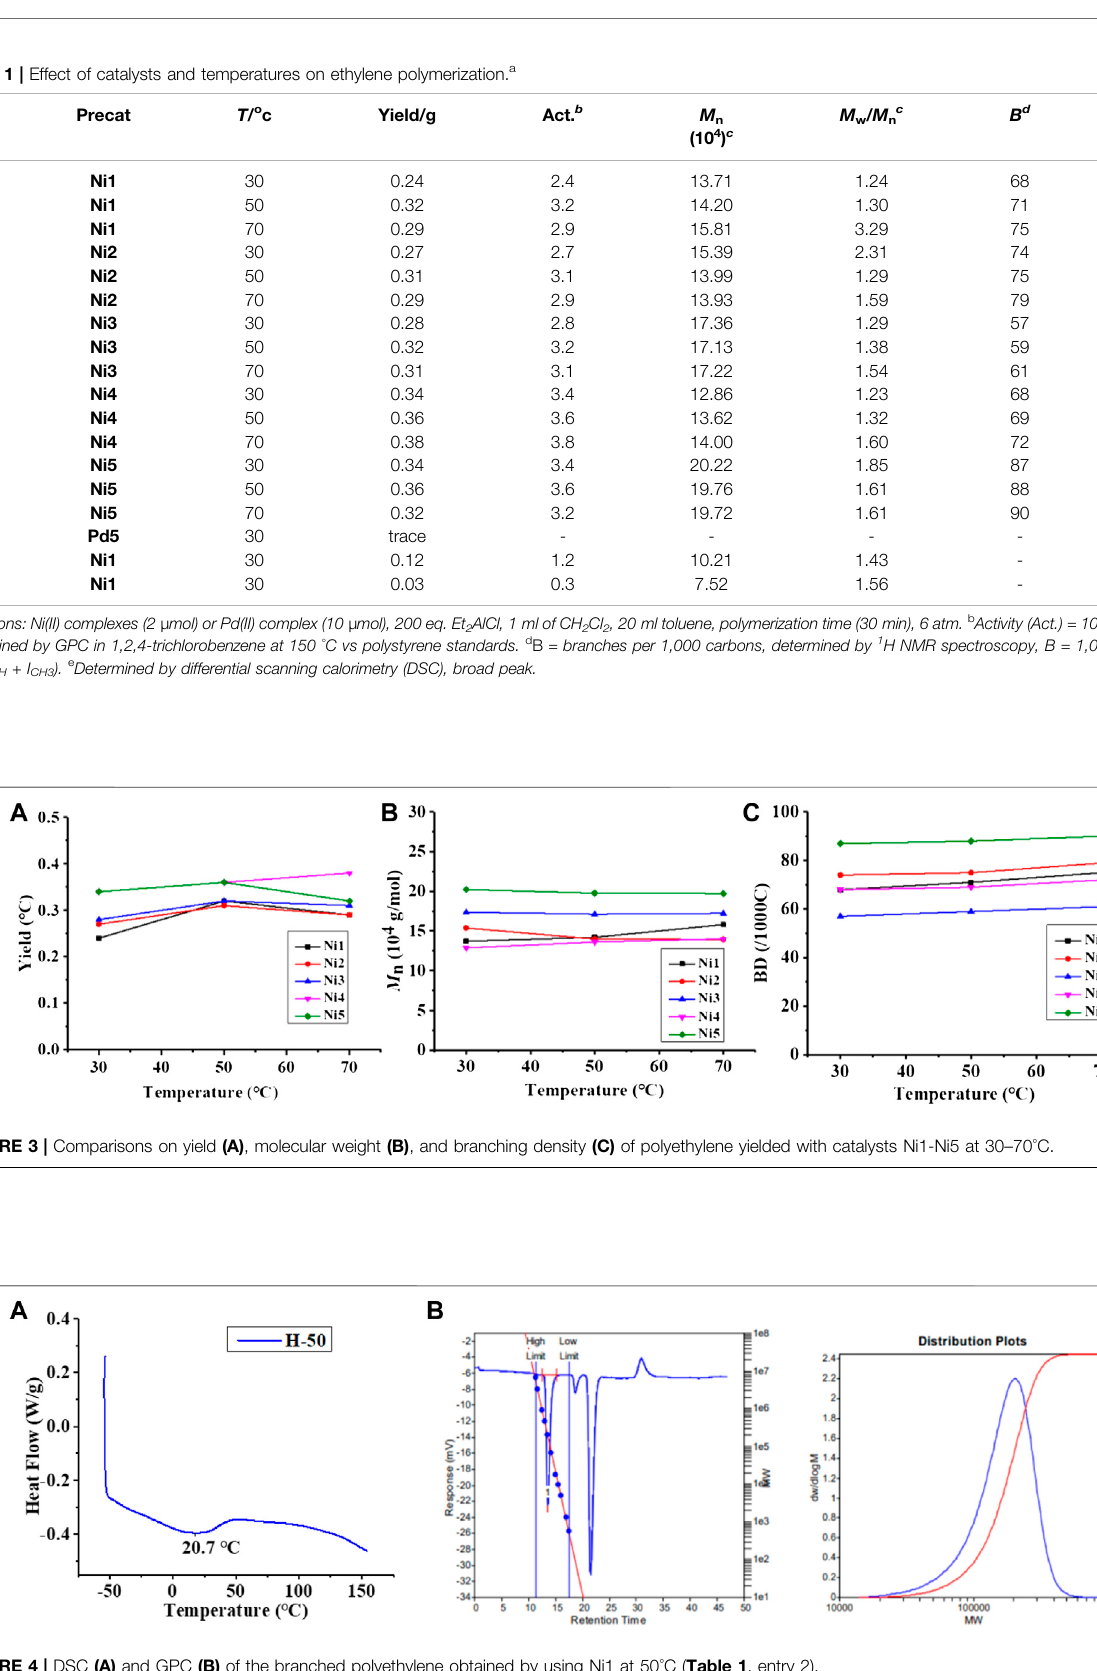
Frontiers in Chemistry |